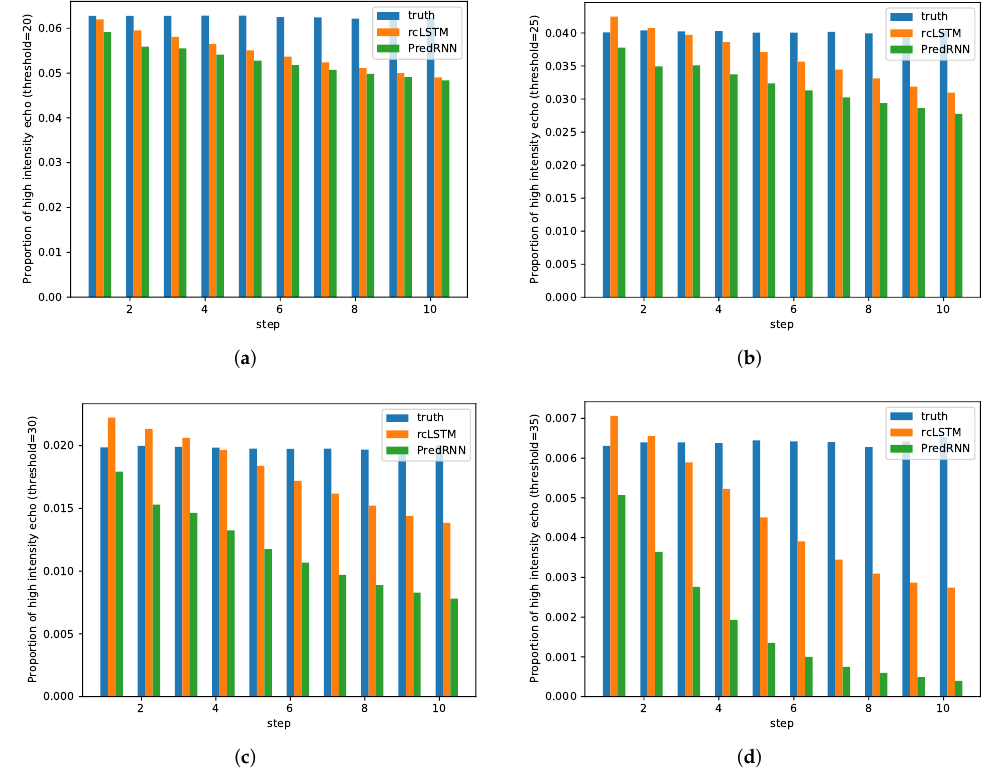
Figure 4. The height of the bar is between 0 and 1, indicating the proportion of echoes in the area that are above the threshold. Among them, the blue one represents the true value, the yellow one is the prediction result of rcLSTM, and the green one represents the PredRNN. In ( a – d ), the thresholds are set to 20, 25, 30, and 35,